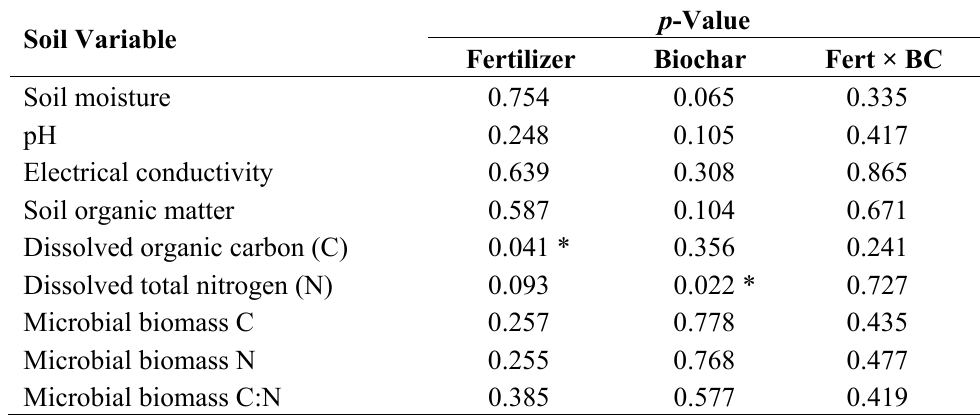
Table 3. Analysis of variance summary of the effects of fertilizer, biochar, and their interaction (Fert × BC) in post-harvest soil and on corn plant